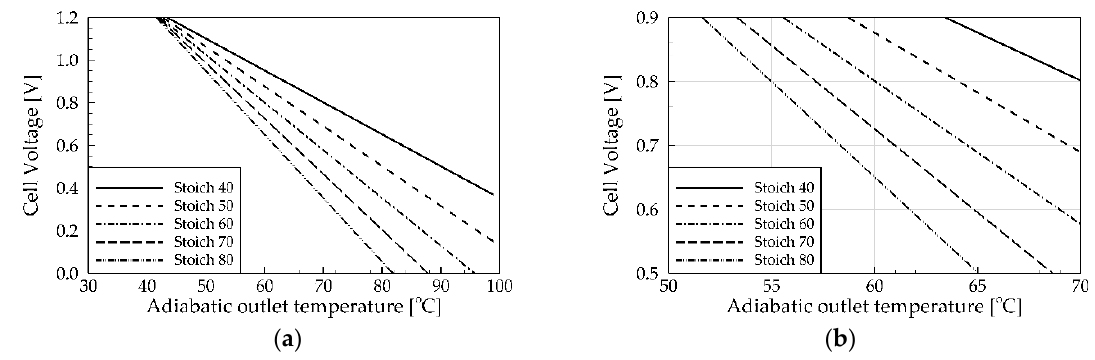
Figure 6. Dependency of the adiabatic outlet temperatures of the product stream on the operating cell voltage. The incoming conditions were a temperature of 40 ° C and a relative humidity of 100 %. ( a ) Entire voltage range, ( b ) close-up on the region of interest.